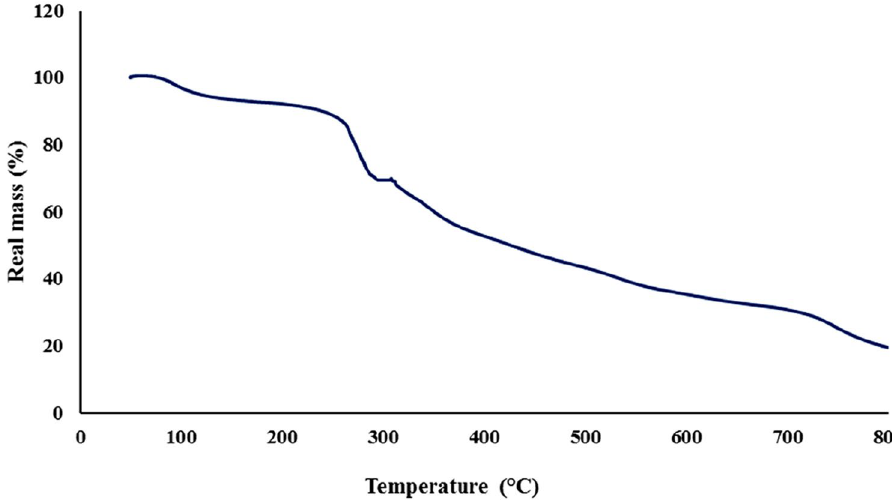
Figure 5. Thermogravimetric curve of synthetic CTT-CS/SF/Mg(OH) 2 nanobiocomposite scaffold.